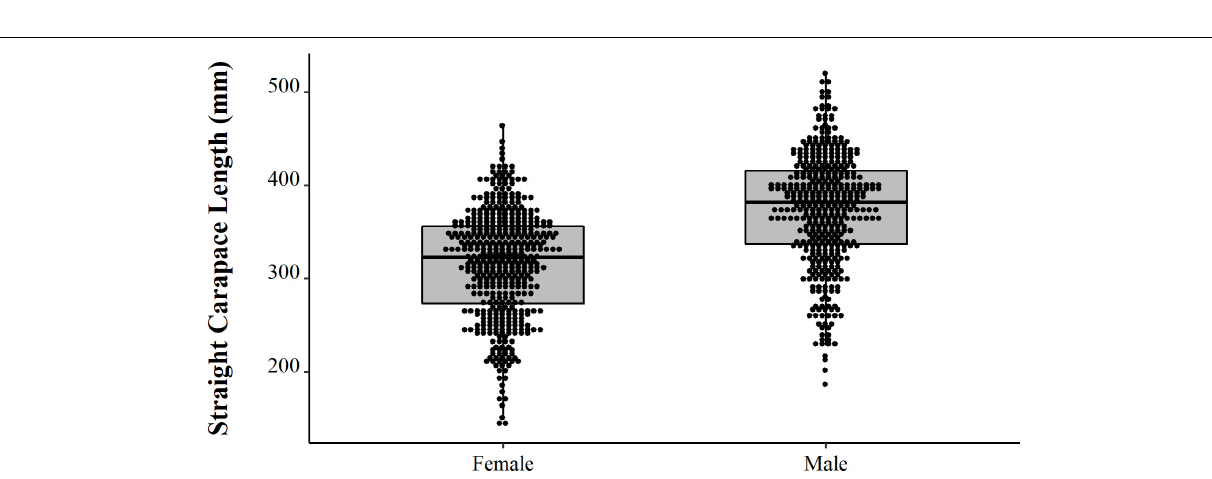
Frontiers in Ecology and Evolution |